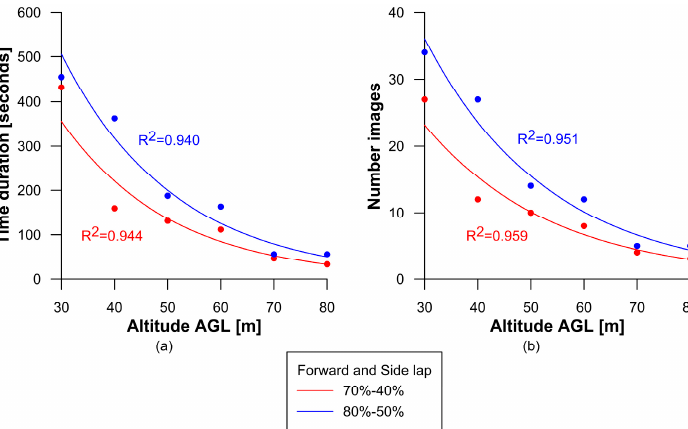
Figure 5. Relationship between altitude above ground level (AGL) and forward and side lap settings on: ( a ) Flight duration and ( b ) Number of images taken.